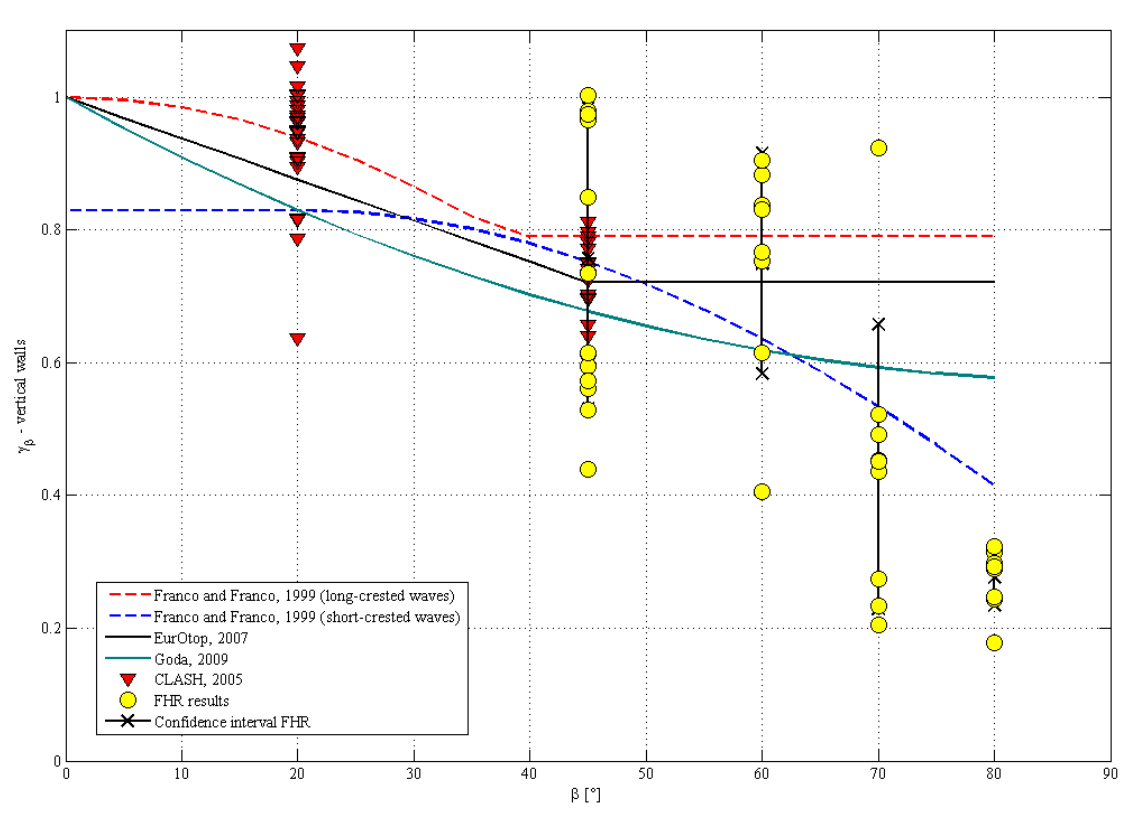
Figure 10. Quay wall: variation of reduction coe ffi cient with wave angle, comparison to existing formulas.